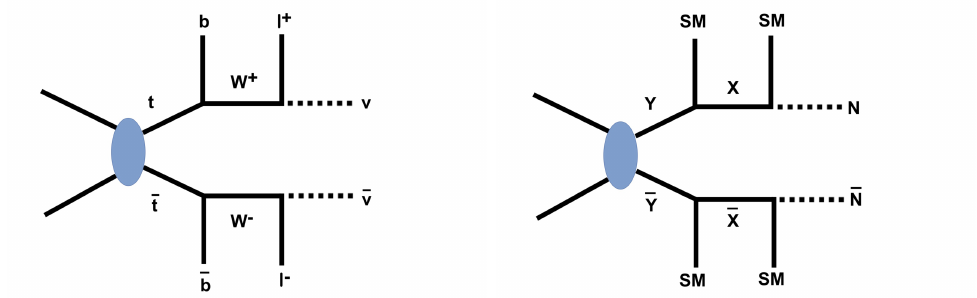
Figure 1 . The existing SM top pair decay with two invisible particles (left) and a similar pair produced generic BSM topology